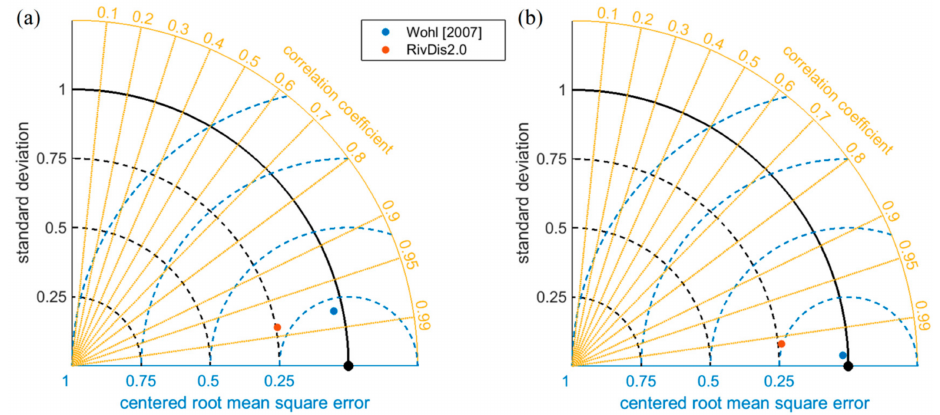
Figure 6. The normalized Taylor diagrams displaying the differences between the annual river discharge values from this study and the existing global river discharge databases for ( a ) eleven river basins and ( b ) nine river basins excluding Congo and Zambezi River